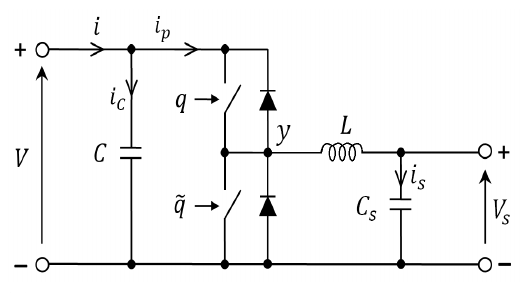
( b ) Charge–voltage characteristics of VIC, comprising the power up, normal operation, and protection regions. Q represents the charge stored in the VIC, the integral of i from subfigure ( a ). Figure 1. Simplified VIC circuit and its charge–voltage